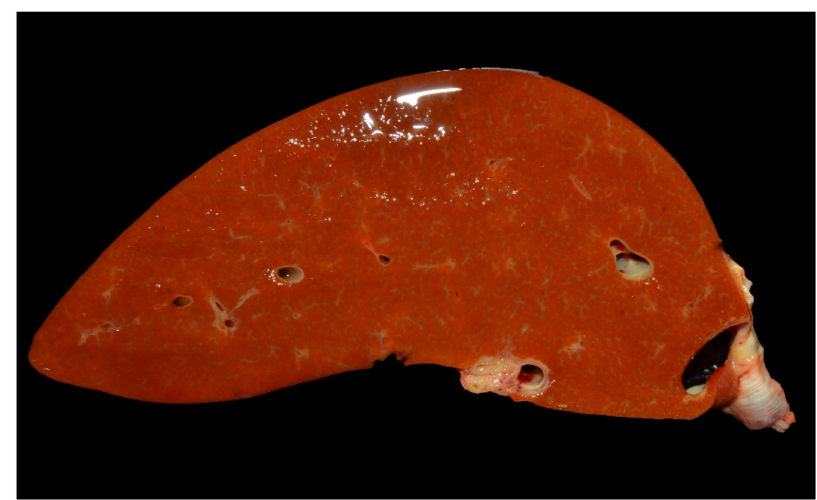
Figure 5. Yellowish, enlarged liver in a lamb with marked icterus.